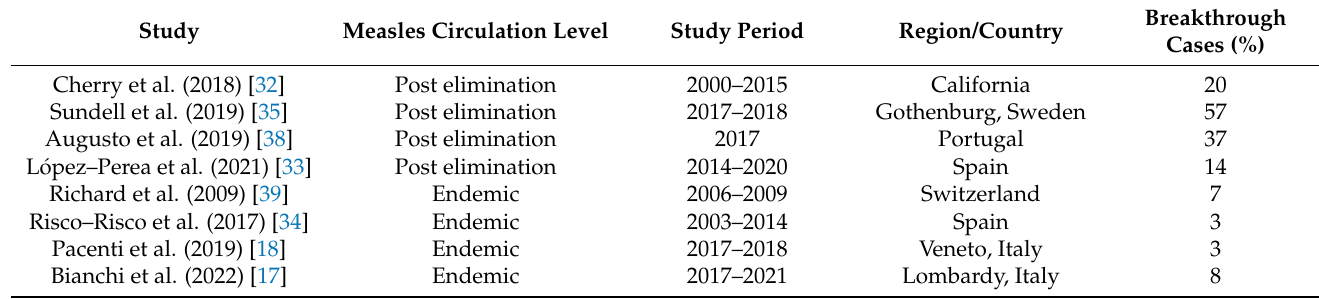
Table 1. Percentage of breakthrough measles cases according to the level of MV